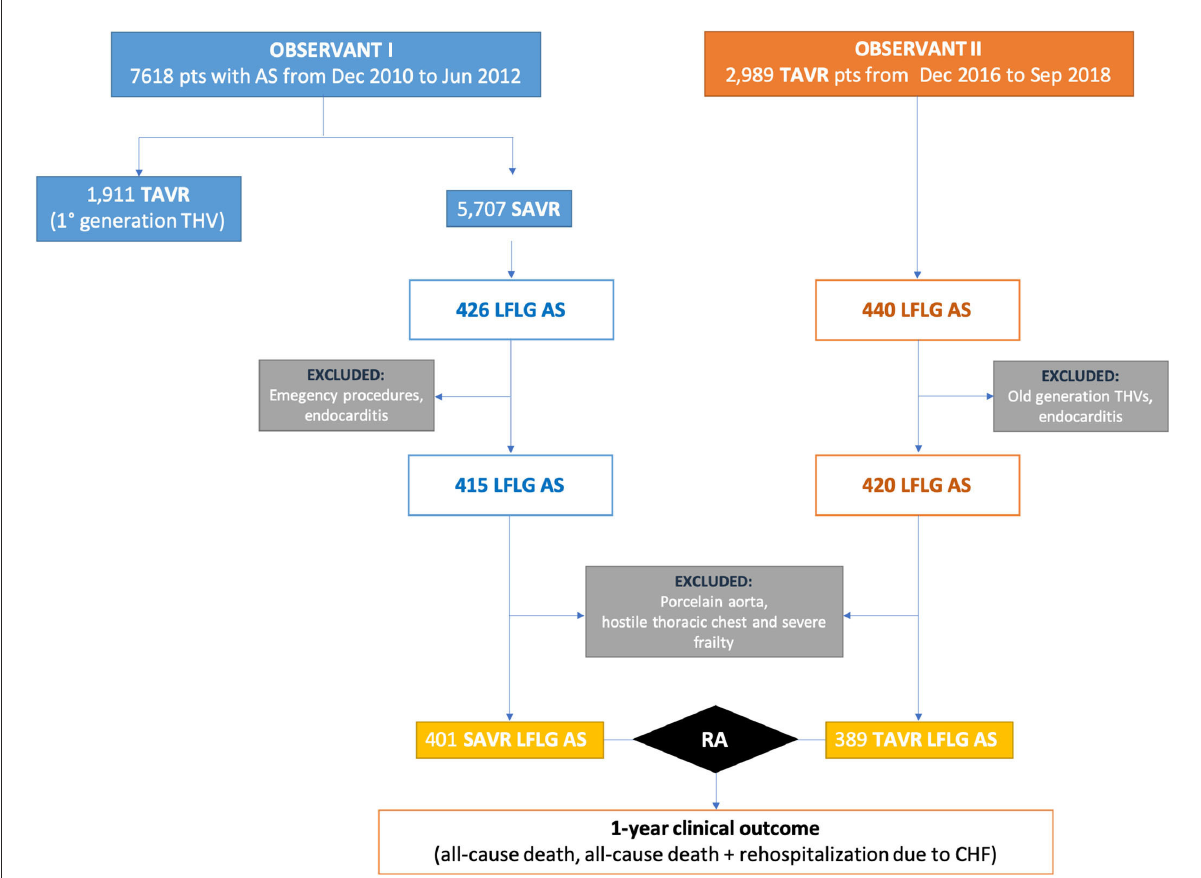
FIGURE1 Study flowchart. AS, aortic stenosis; LFLG, low-flow–low-gradient; RA, risk adjustment; SAVR, surgical aortic valve replacement; TAVR, transcatheter aortic valve